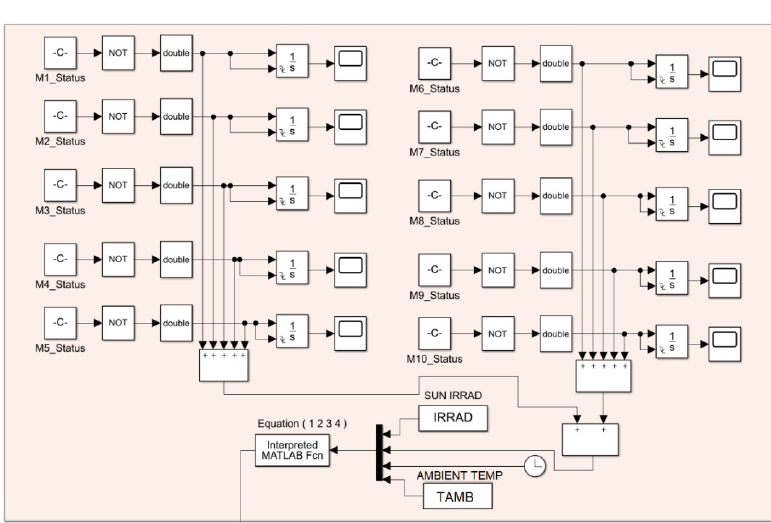
Figure 7. Simulink implementation of the PVM section.